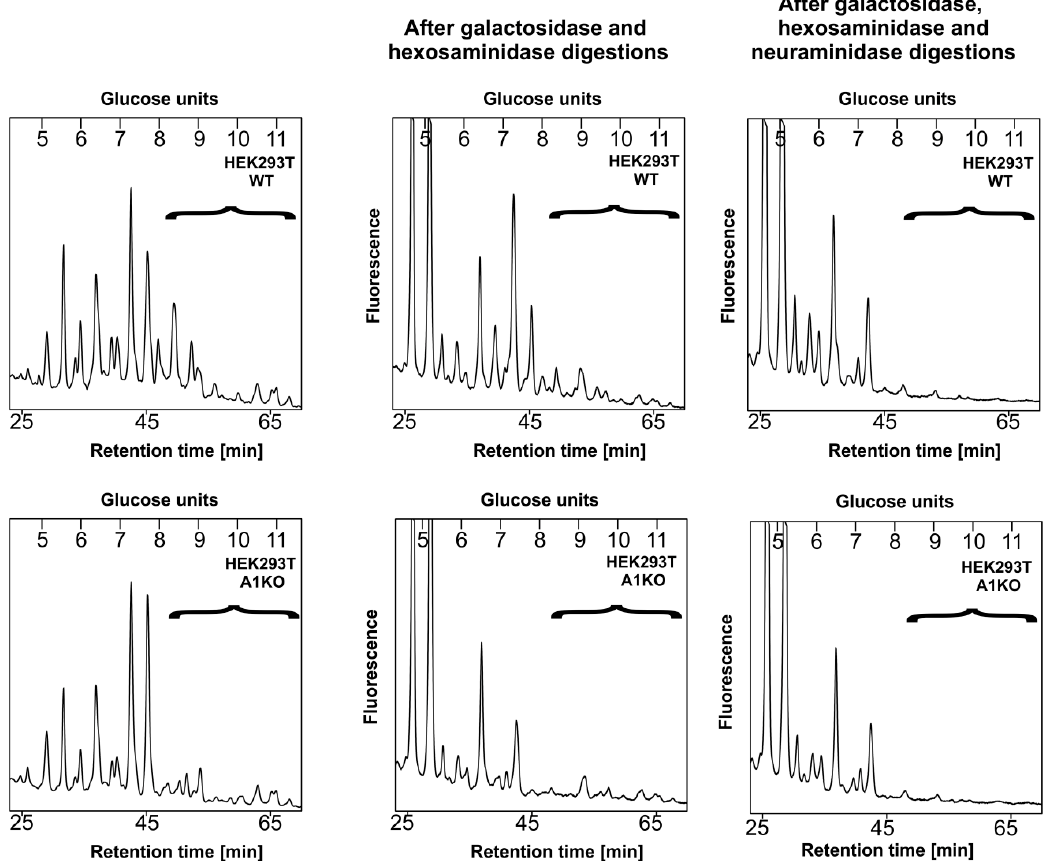
Figure 6. HPLC analysis of N-glycans released from the secreted reporter glycoprotein. N-glycans derived from a modified SEAP overexpressed in wild-type (WT, top panel) and CST-deficient (A1KO, bottom panel) HEK293T cells were fluorescently labeled with 2-AB, purified and separated on the normal phase GlycoSep N column using HPLC. The left panel represents intact (undigested) structures; the middle panel reflects structures obtained upon a combined digestion with galactosidase and hexosaminidase; and the right panel reflects structures obtained upon a digestion with neuraminidase followed by a combined digestion with galactosidase and hexosaminidase. Respective glycans are expressed in glucose units. Sialylated structures are enclosed in brackets. Representative data from two independent analyses with similar tendencies are shown. A1, SLC35A1.